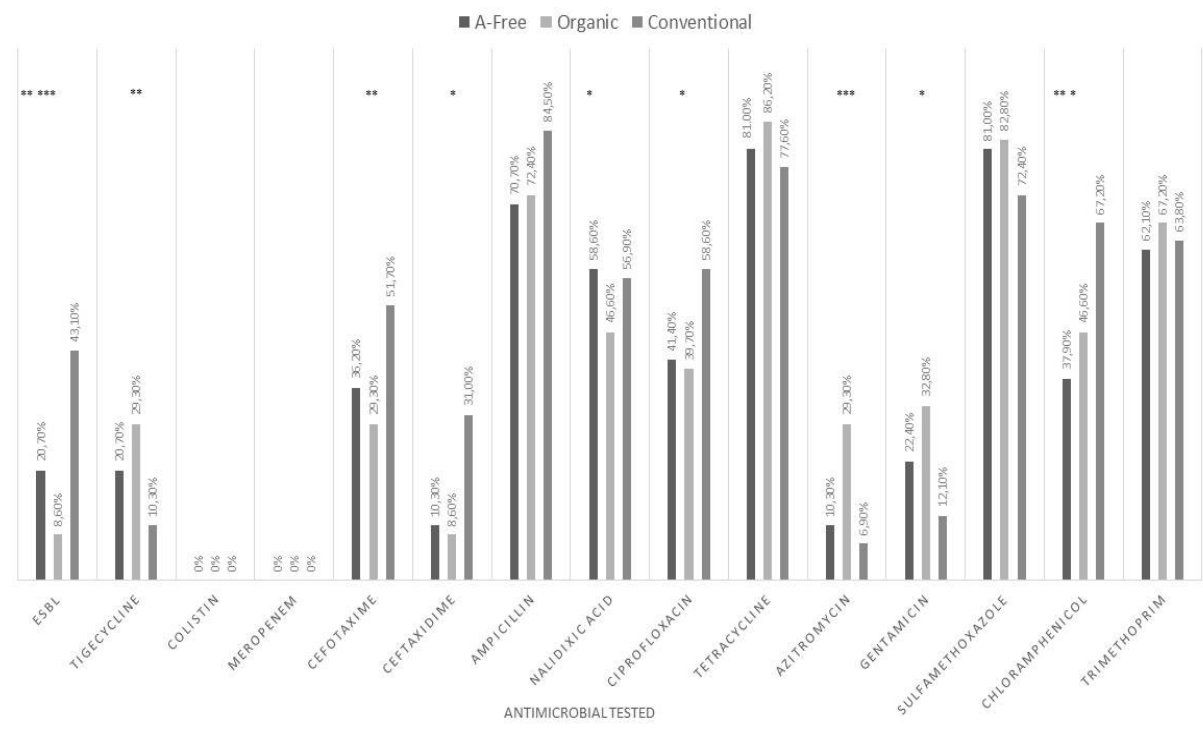
Figure 1. Prevalence of antimicrobial-resistant E. coli strains in conventional, organic and antibiotic-free systems. * p ≤ 0.05; ** p ≤ 0.01; *** p ≤ 0.001. Table 1. Multivariate logistic regression analysis for ESBL E. coli , MDR E. coli strain prevalence and E. coli antimicrobial susceptibility (only significant ORs, and their 95% confidence interval, are reported in the table).